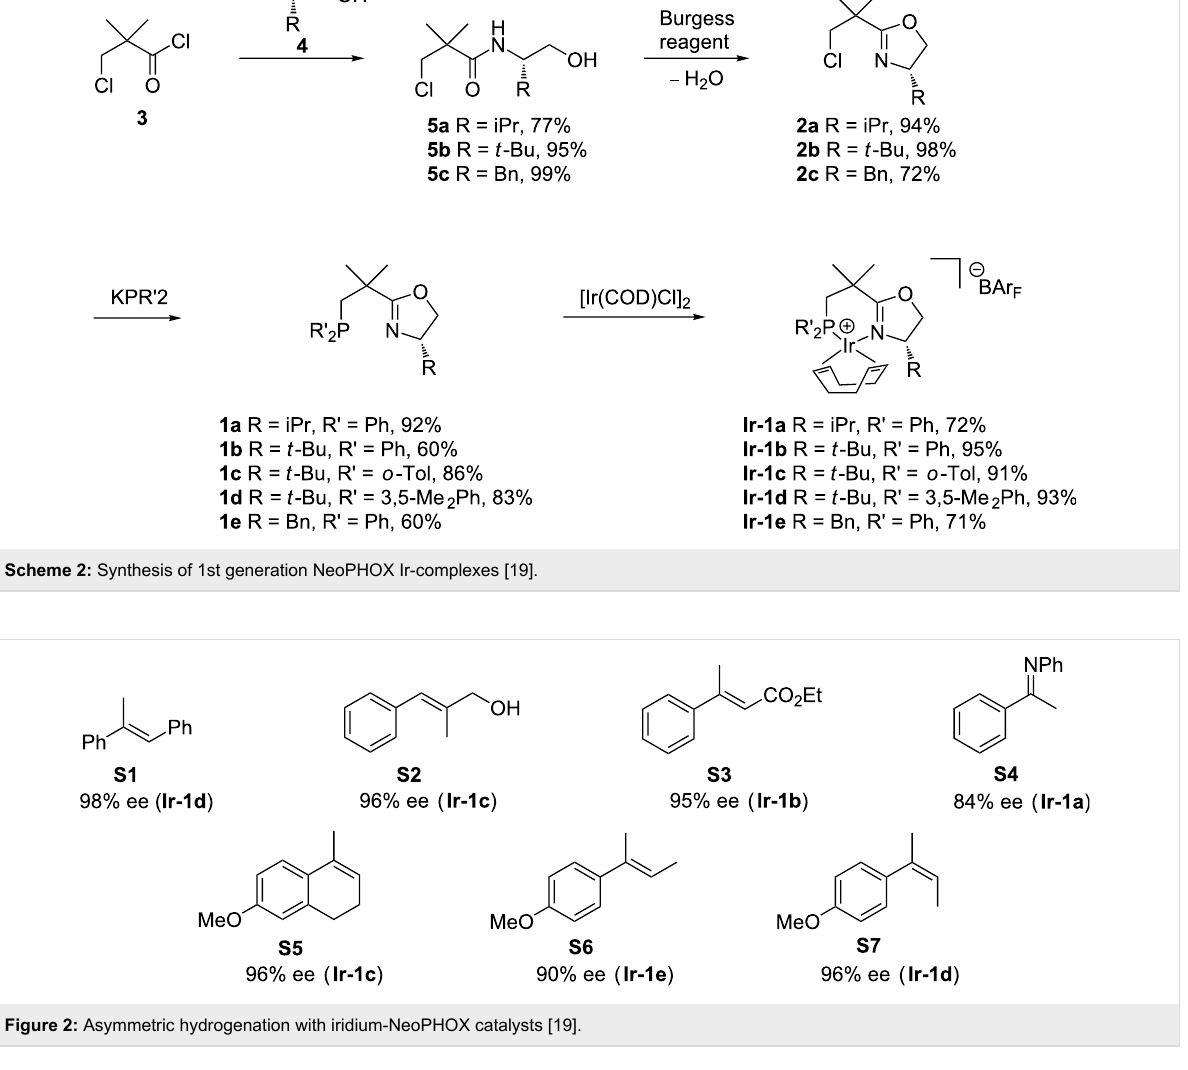
An option, which had been previously used in the development of PHOX ligands [23-27], is to replace the tert -butyl group by an isopropyl group and at the same time introducing two bulky substituents at C(5) (see Figure 3). Ligands of this type are accessible from valine, which is much less expensive than tert - leucine. The steric hindrance exerted by the geminal substitu- ents at C(5) is expected to direct the isopropyl methyl groups toward the coordination sphere, creating a steric environment which resembles that of a tert -butyloxazoline ligand.